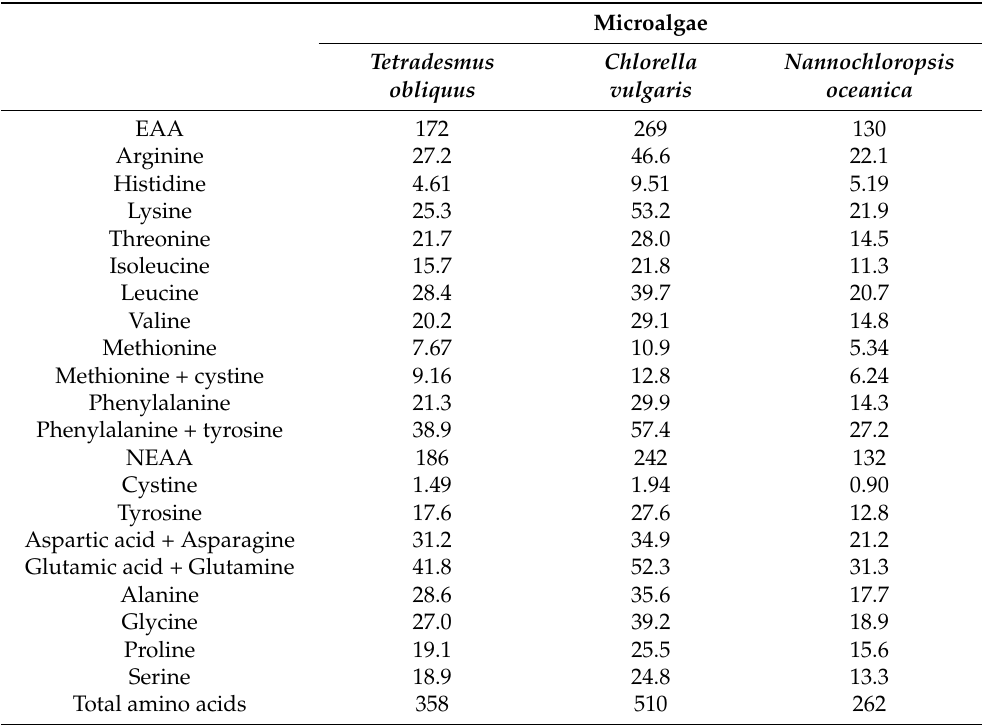
Table 2. Analyzed content of essential amino acids (EAA) and non-essential amino acids (NEAA) of the studied microalgae species (g kg − 1 dry matter).